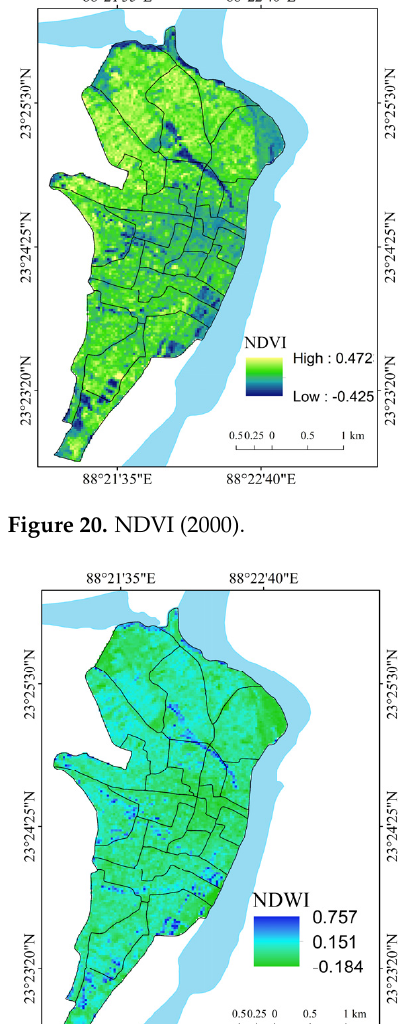
Figure 19. Flow length line density (2000).